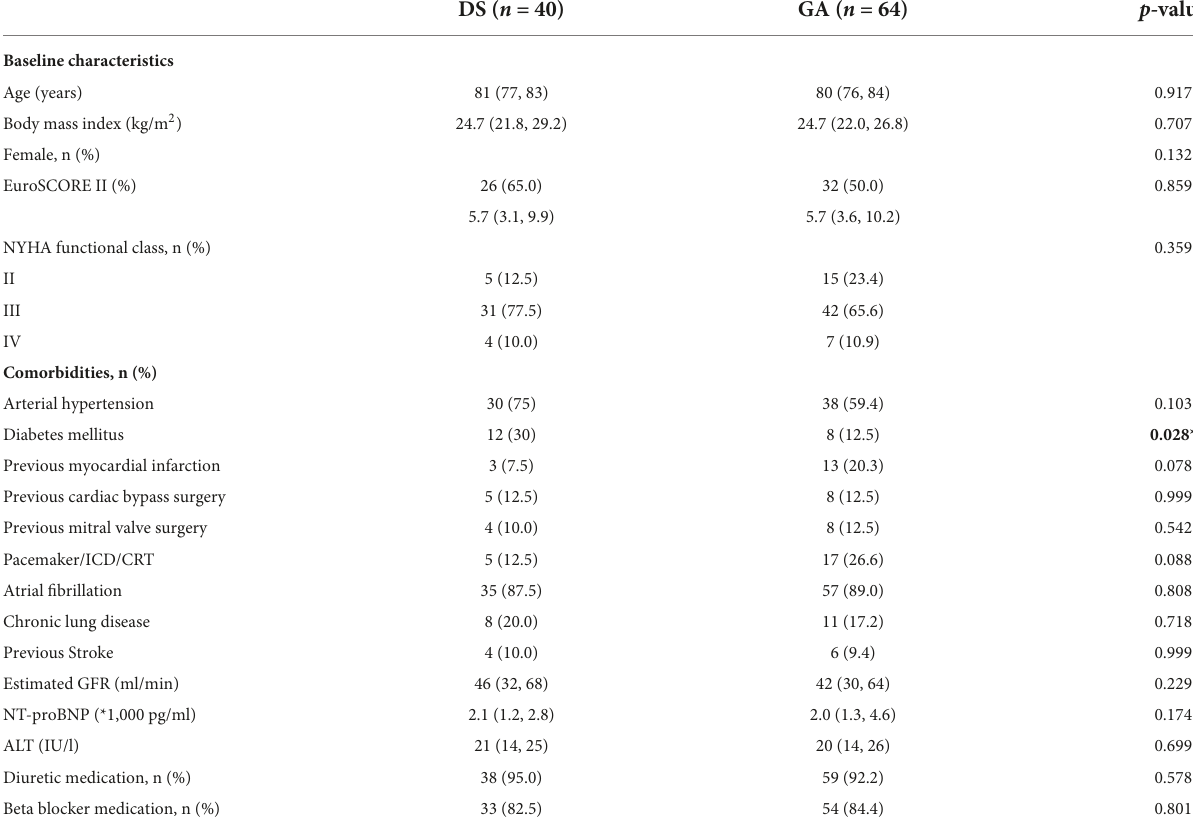
TABLE 1 Characteristics of TTVr patients grouped according to the anesthesia (GA or DS) used.